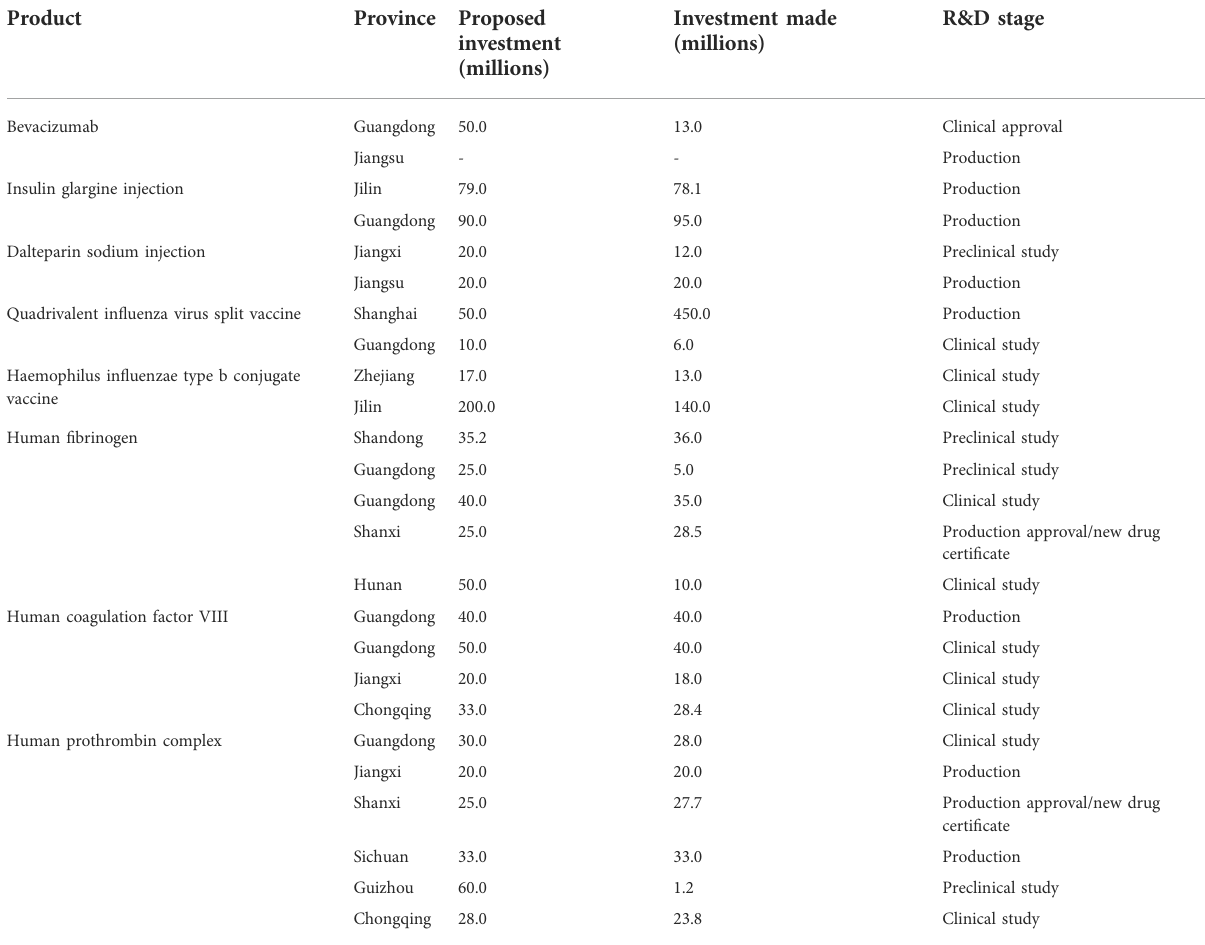
TABLE 4 Products in development in multiple biopharmaceutical